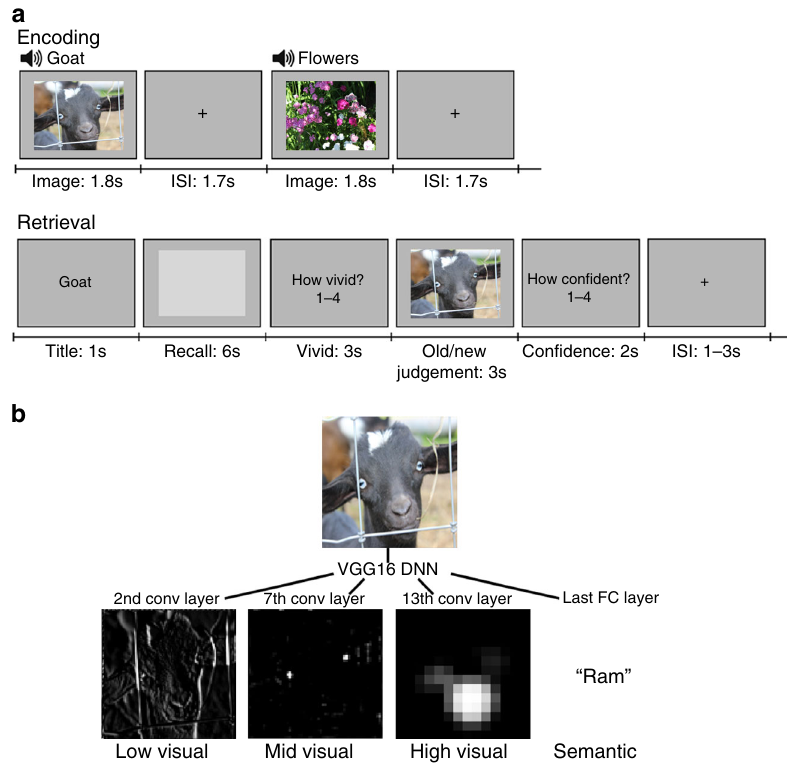
Fig. 1 Procedure and visual features. a Alternating image encoding and retrieval tasks. During encoding, participants performed a 1-back task while viewing a sequence of color photographs accompanied by matching auditory labels. During retrieval, participants (1) were cued with a visually presented label, (2) retrieved and maintained a mental image of the associated photograph over a 6 s delay, (3) indicated the vividness of their mental image using 1 – 4 scale, (4) decided whether a probe image matched the cued item, and (5) entered their con fi dence rating with respect to the old/new judgment. b For each image, features were extracted from layer node activations using the VGG16 deep neural net (DNN). Activations from the 2nd, 7th, and 13th convolutional (conv) layers, and the last fully connected layer were used, corresponding to low-visual, middle-visual, high-visual, and semantic (visual object semantics) features, respectively. Owing to copyright concerns, images used in the study could not be included in the fi gure. The images depicted in the fi gure are for explanatory purposes only.